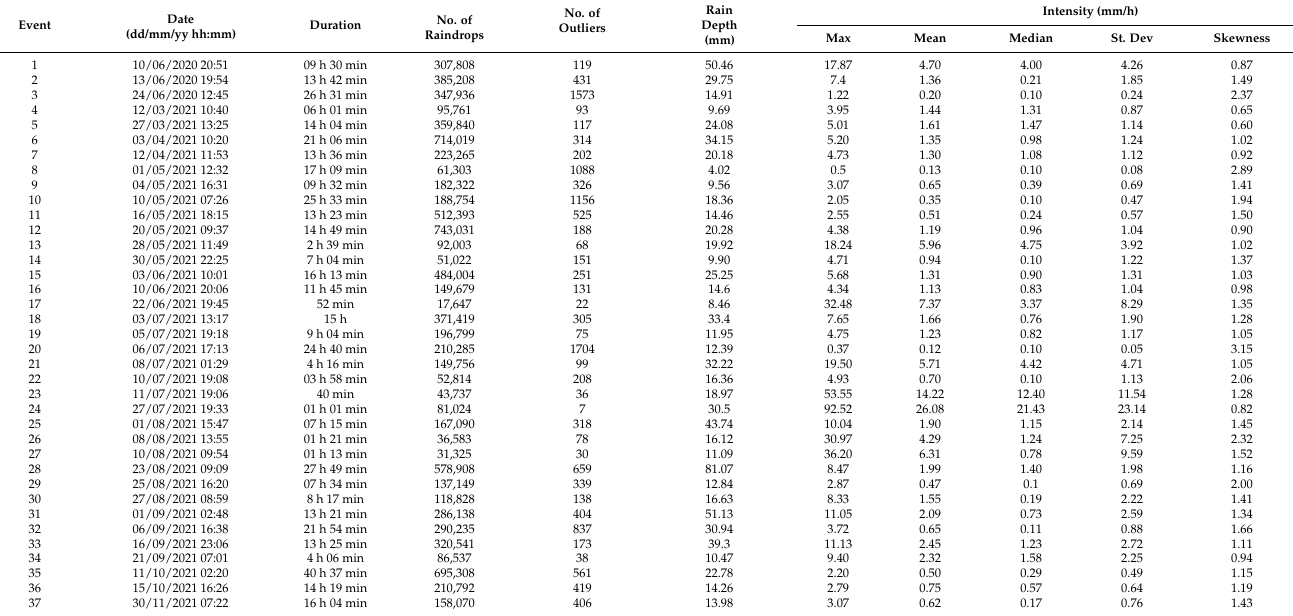
Figure 3. Flowchart of the study. Table 1. Information of specified precipitation